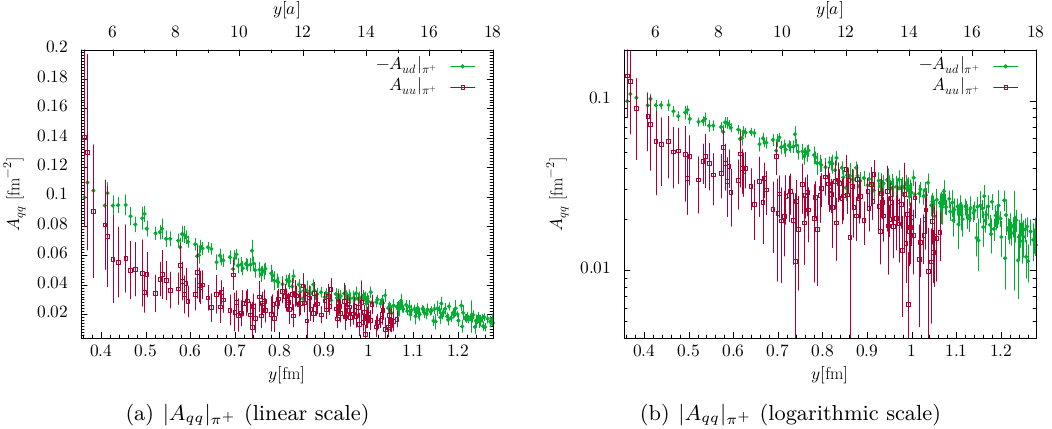
Figure 25 . Comparison of the twist-two functions − A ud and A uu in a π + . The data are the same as shown in figures 23(a) and 23(c). Points with very large errors have been omitted for the sake of